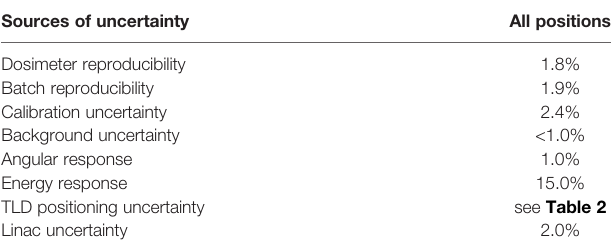
TABLE 1 | Sources of thermoluminescent dosimeter uncertainties ( k = 1).